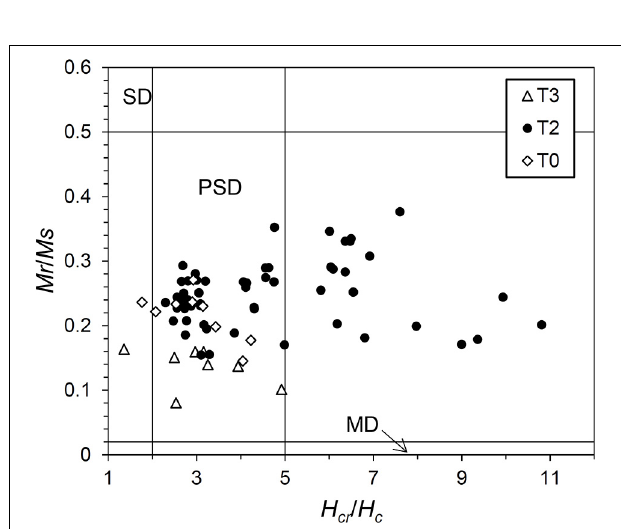
FIGURE 7 | Dunlop-Day (Day et al., 1977; Dunlop, 2002) plot for samples from the T3, T2, and T0 profiles. SD, Single-domain magnetic grains; PSD, Pseudo-single domain magnetic grains; and MD, Multi-domain magnetic